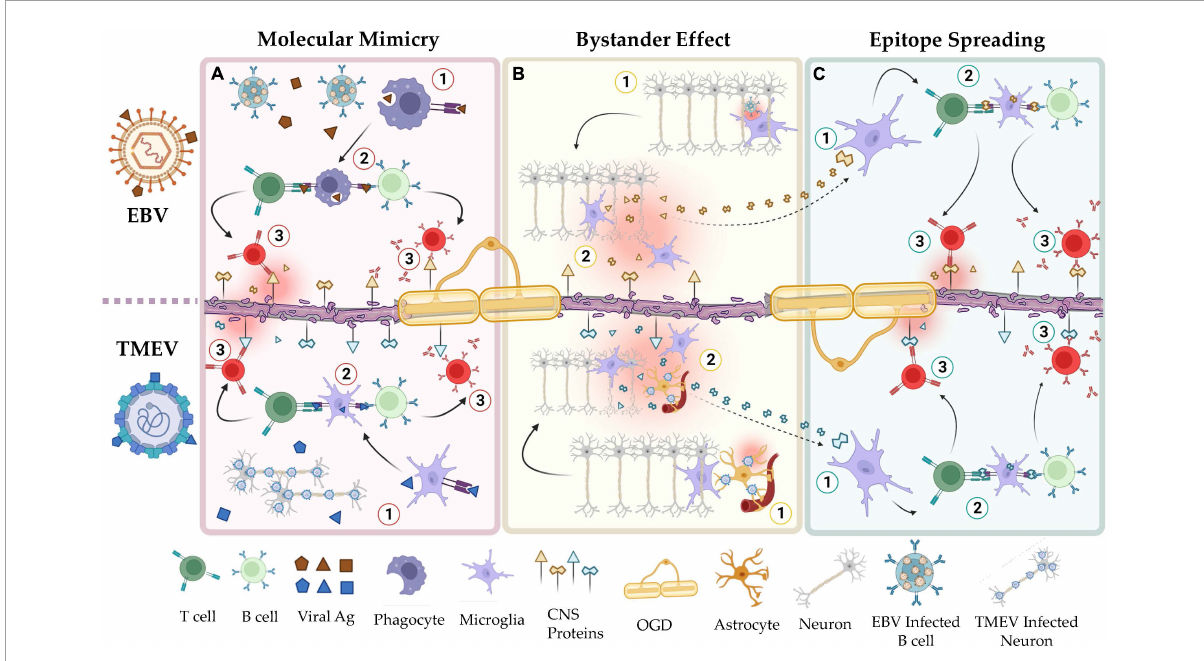
FIGURE1 Shared mechanisms of autoimmunity in the viral hypotheses of MS and the TMEV-IDD model of MS. (A) Mechanisms of molecular mimicry in EBV (top) and TMEV infection (bottom). Viral peptides, e.g., EBNA-1, share structural homology with CNS resident self-peptides, e.g., GlialCAM. Natural immunization to these viruses induces autoimmunity toward the CNS resident proteins. (B) Mechanisms of bystander effect in EBV (top) and TMEV infection (bottom). Responses by resident immune cells to latent or reactivated virus in the CNS induces collateral damage to adjacent tissues. (C) Mechanisms of epitope spreading in EBV (top) and TMEV infection (bottom). Peptides released by apoptotic or damaged cells are used to activate self-reactive lymphocytes. In a positive feedback cycle, the autoimmune reaction by these cells releases additional cellular debris. As this cycle continues, the set of self-peptides that are recognized by auto-reactive lymphocytes increases via clonal expansion. This figure was illustrated using